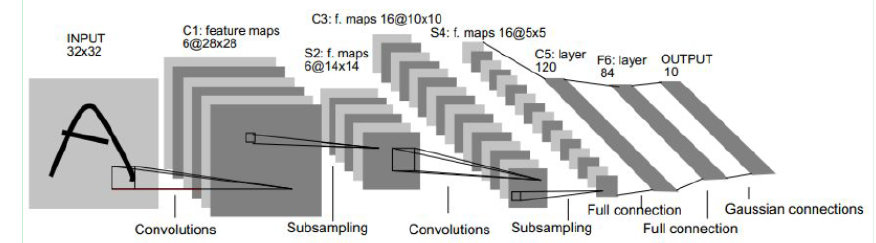
Figure 5. Construction of the